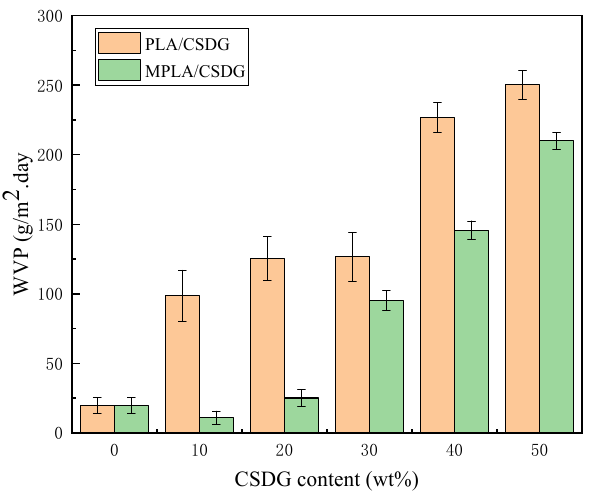
Figure 10. Water vapor barrier properties of PLA/CSDG and MPLA/CSDG composites.